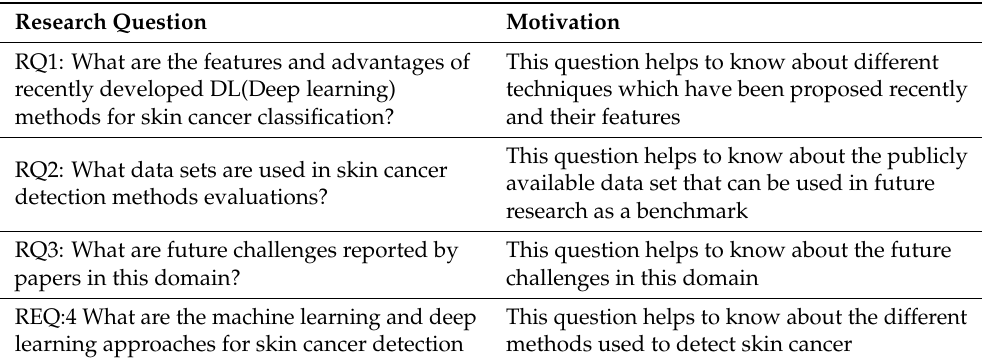
Figure 2. SLR methodology process. Table 1. The research